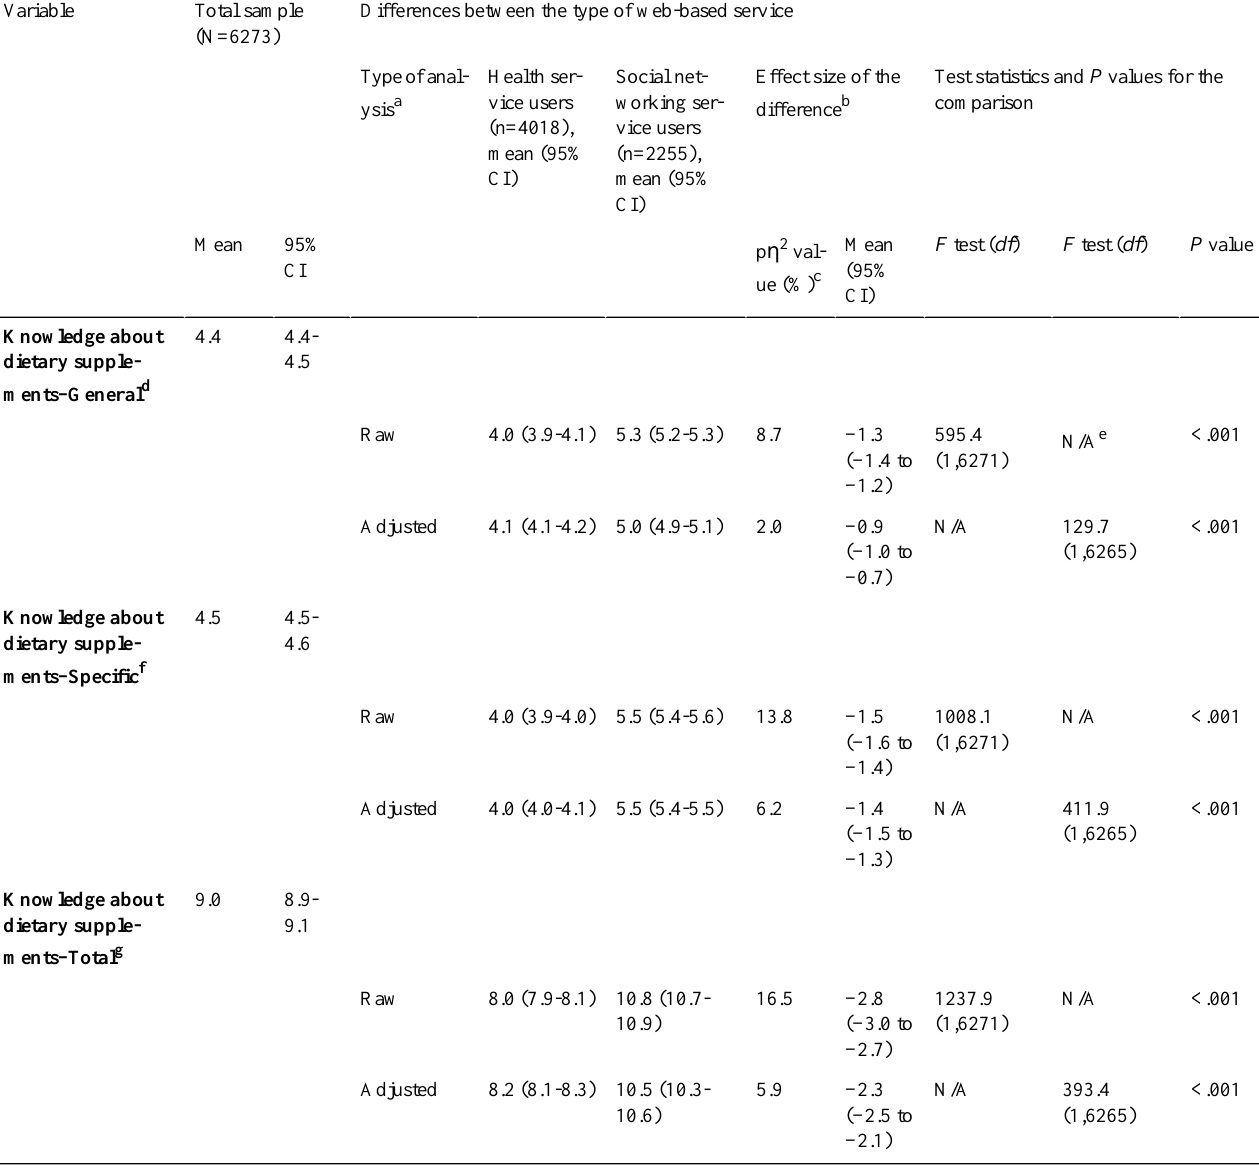
Table 2. Knowledge about dietary supplements among web-based health service users and social networking service users.